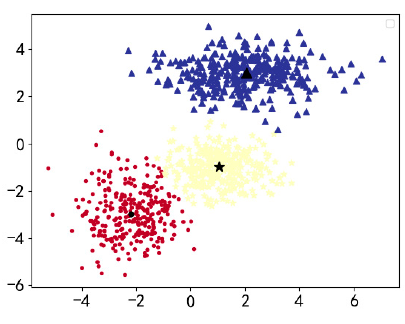
Figure 4. Results of fuzzy clustering.